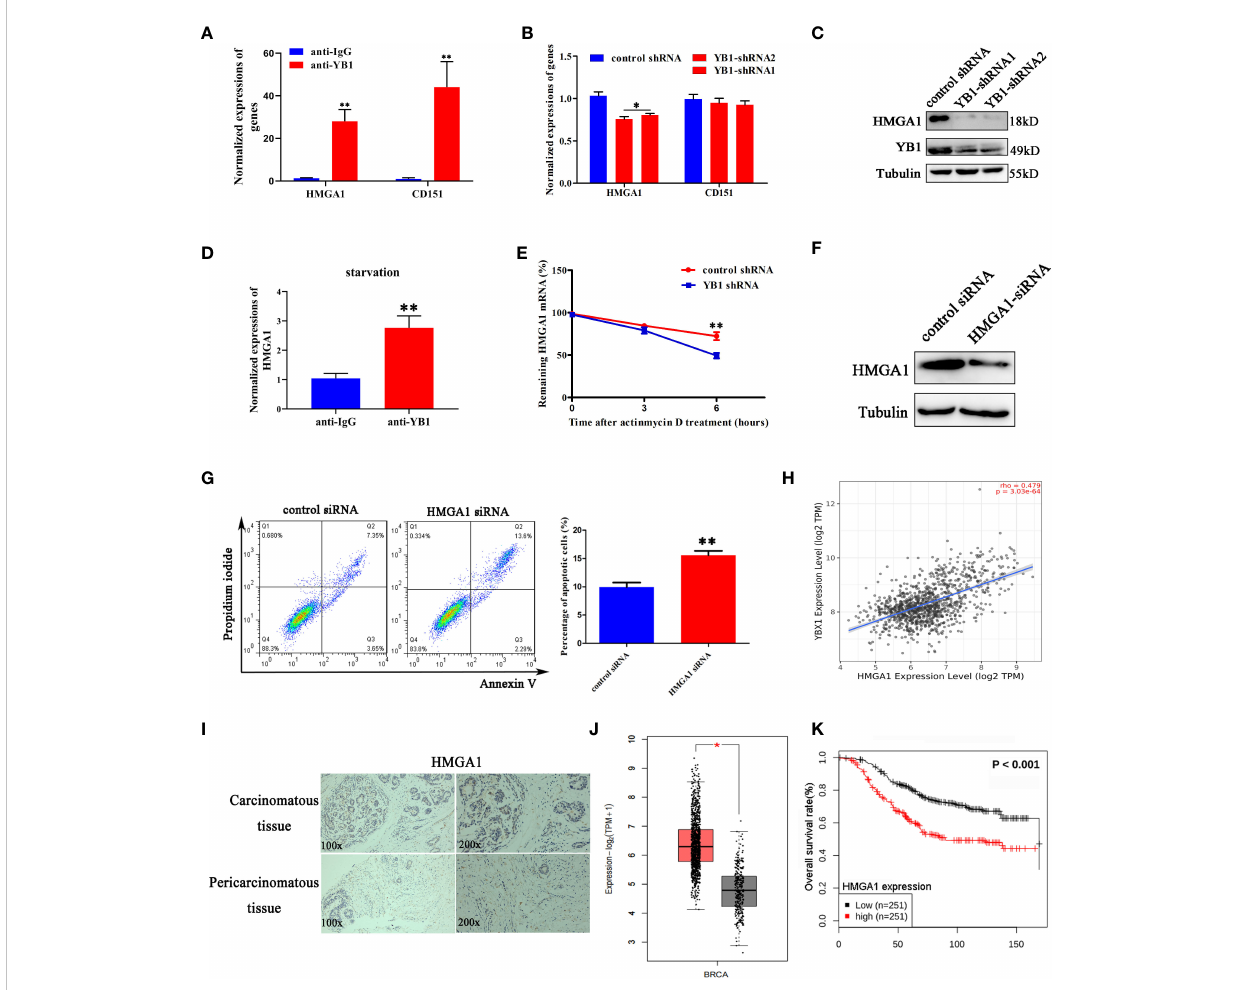
FIGURE 5 YB1 maintained the stability of HMGA1 mRNA. (A) Detection of oncogenes in the YB1-bound RNA library through RIP assays. (B, C) YB1 knockdown signi fi cantly downregulated HMGA1 expression at both mRNA level and protein level. (D) Serum-free starvation impaired YB1 binding ability with HMGA1 mRNA. n = 3,**p < 0.01. (E) In fl uence of YB1 knockdown on HMGA1 mRNA degradation. (F) The expression of HMGA1 was silenced using siRNA. (G) In fl uence of HMGA1 knockdown on cell apoptosis. n = 3, **p < 0.01. (H) Correlation analysis of YB1 expression with HMGA1 expression in breast cancer tissues. Data were downloaded from website http://timer.comp-genomics.org. (I) Immunohistochemical analysis of HMGA1 in paired breast carcinoma and paracarcinoma tissues. (J) Analysis of HMGA1 expression in breast cancer tissues and normal tissues through referring to an online database (http://gepia.cancer-pku.cn/). *p < 0.05. (K) High expression of HMGA1 in breast cancer tissues predicts adverse clinical survival outcomes